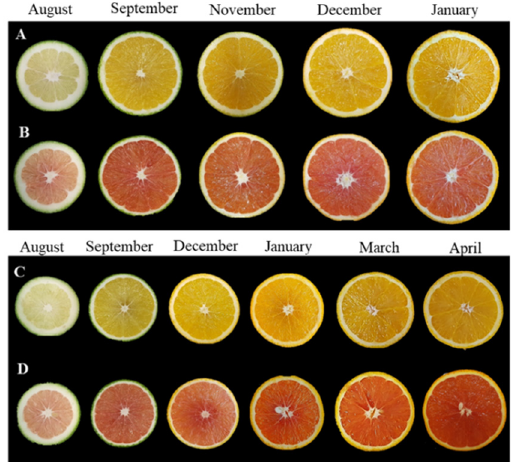
Figure 1. Internal appearance of the Navel ( A ), Kirkwood ( B ), Valencia ( C ) and Ruby ( D ) orange fruits used in this study.